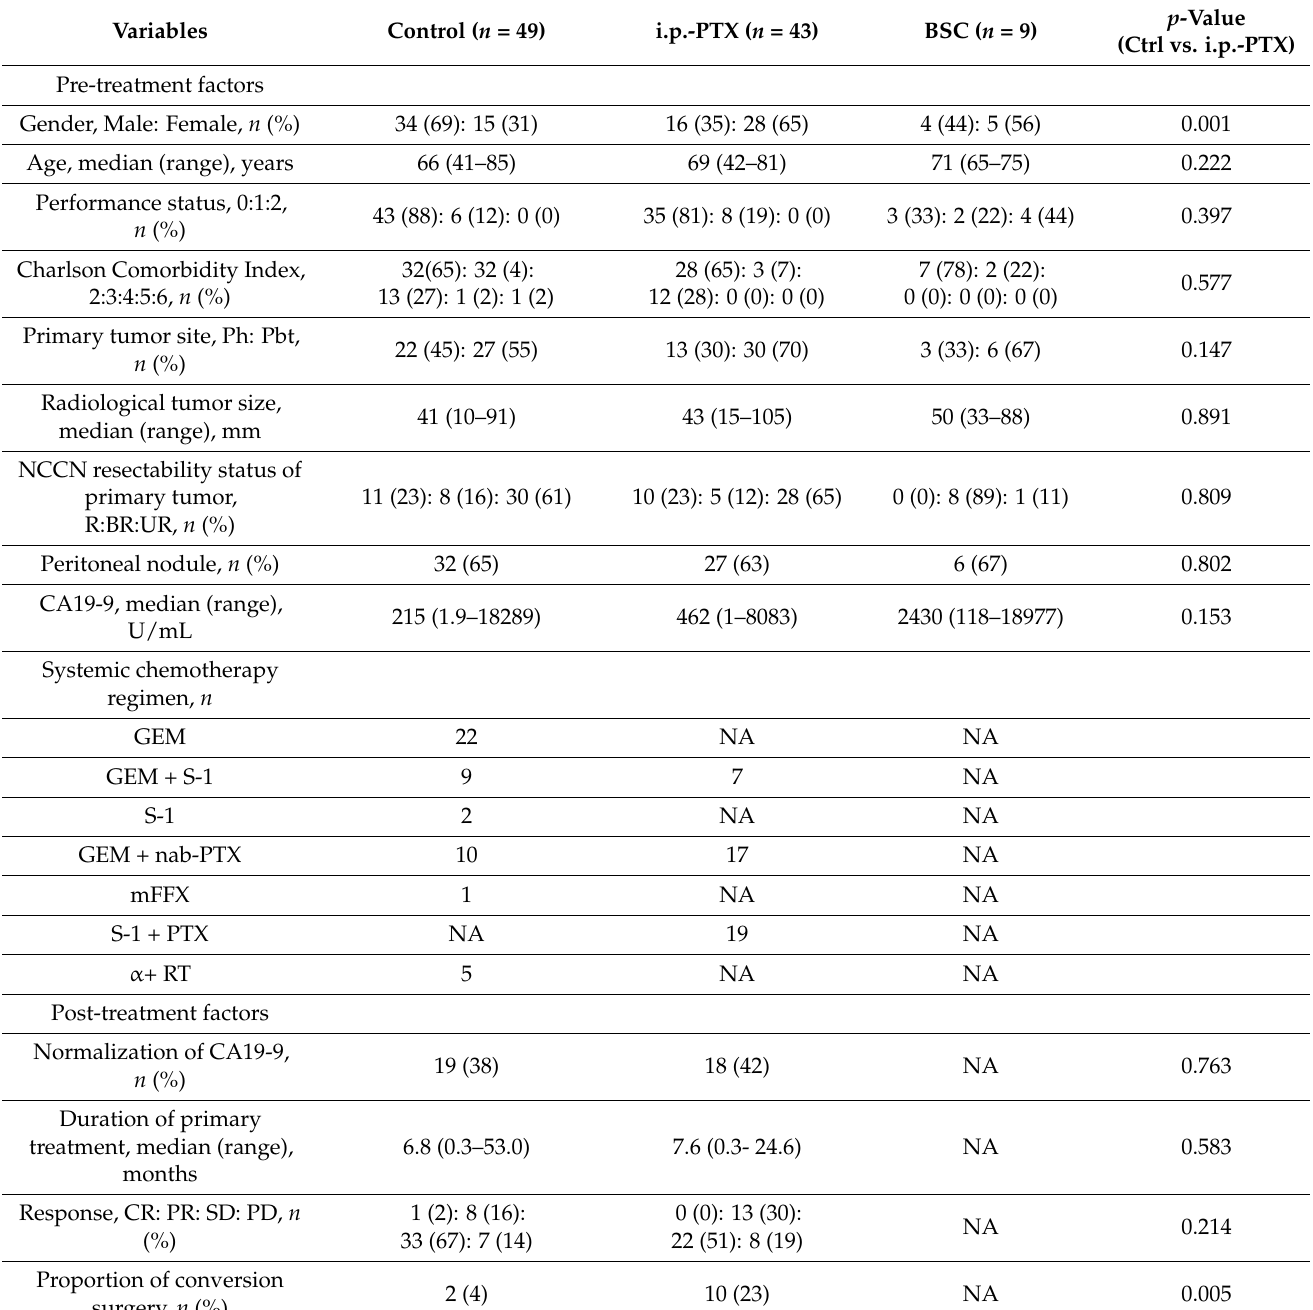
Table 1. Patient